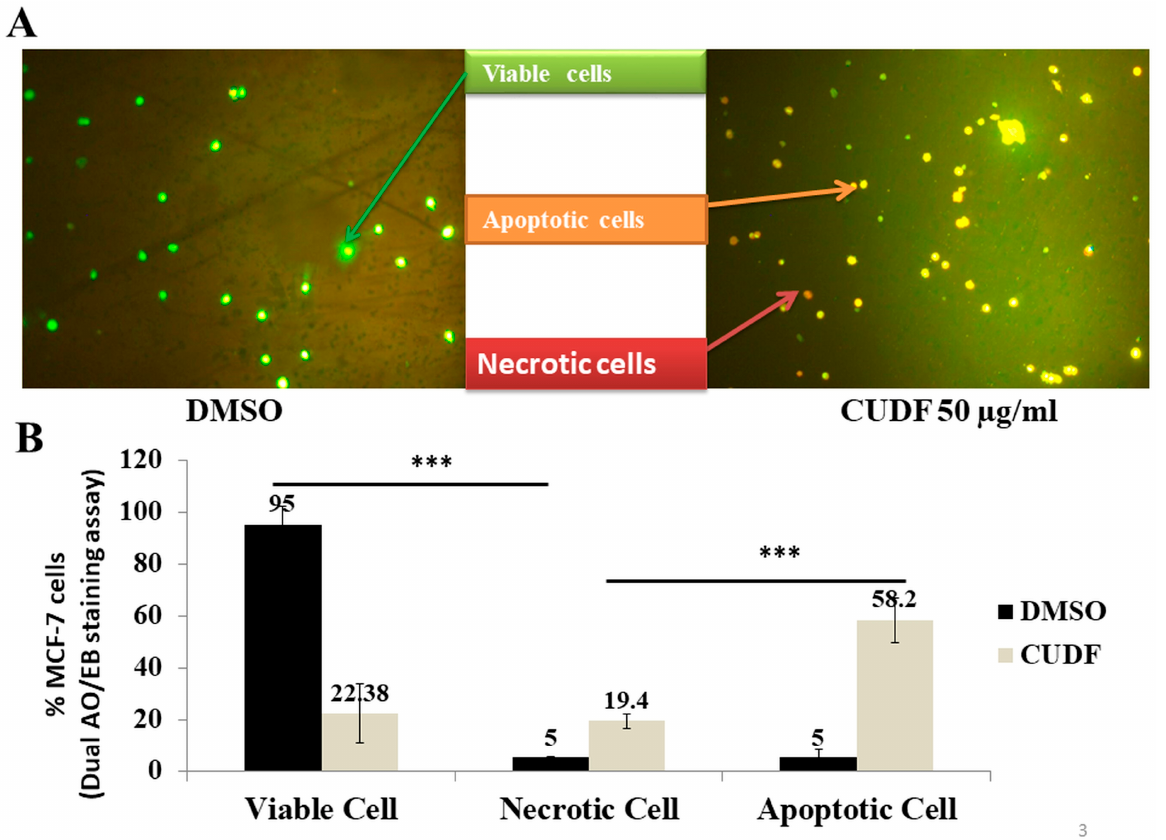
Figure 3. CUDF displays the presence of apoptotic cells in MCF-7 cancer cells by dual acridine orange (AO)/ethidium bromide (EB) staining. ( A ) MCF-7 cancer cells were treated with DMSO and CUDF (50 µg/mL) for 72 h. At the end of incubation, cells were harvested and processed for acridine orange (AO)/ethidium bromide (EB) staining as described in the Experimental Procedure section. Fluorescent microscopic images were captured at 40× magnification. ( B ) The percentages of viable cells, necrotic cells, and apoptotic cells among MCF-7 cancer cells were estimated by counting cells differentially stained with AO/EB. Green color: normal cells; yellow-green fluorescence by acridine orange (AO): early apoptotic cells; crescent or granular group of cells shows: late apoptotic cells; EB-stained orange fluorescence: necrotic cells. Data are represented as mean ± SD. Each experiment was conducted independently three times. The bar graph without an asterisk denotes no significant difference compared to the DMSO control. *** Significantly different from the DMSO control at a p -value ≤ 0.001. To estimate the apoptosis-inducing potential, DMSO- and CUDF-treated MCF-7 cancer cells were stained with annexin V and PI and measured using a flow cytometer. The scatter plot of the distribution of viable cells, non-viable cells, early apoptotic cells, and late apoptotic cells in DMSO, and CUDF-treated MCF-7 breast cancer cells is presented in Figure 4A. A reduction in cell viability of MCF-7 cancer cells from 79.64% (DMSO control) to 60% is observed due to CUDF treatment (Figure 4B). Based on the cell counts during the annexin/PI staining assay, the percentage of apoptotic MCF-7 cells was calculated and normalized to the DMSO control, appreciably showing the presence of 58.27% apoptotic cells in CUDF-treated MCF-7 cells relative to the DMSO control (Figure